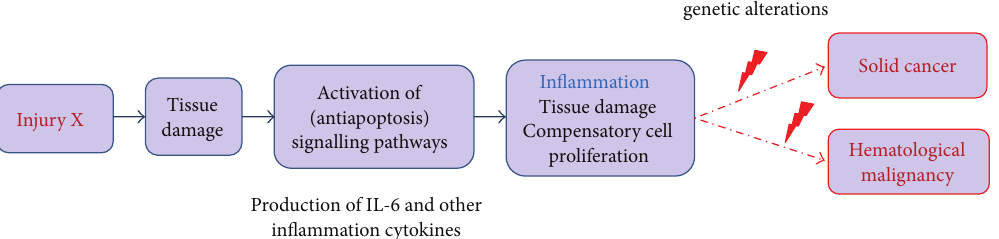
Figure 1: Progression from chronic inflammation to solid and blood cancers. A physical, chemical, or infectious injury leads to tissue and cell damage and activation of antiapoptosis signaling pathways in affected cells, which results in the autocrine and paracrine production and consumption of prosurvival, inflammatory cytokines, as well as chemokines, to attract immune cells of the lymphoid and myeloid lineages to thesiteofinjury.Overtime,establishedinflammation(chronicinflammation)constantlyoverstimulatestheproductionofhematopoieticcells and induces more tissue and cell damage, hereby increasing the rate of DNA duplication and risk of defective DNA reparation and mutation, bothincellsfromaffectedtissues(increasedriskofsolidcancer)andinlymphoidandmyeloidcellsparticipatingintheimmune/inflammatory response (increased risk of hematological malignancy).